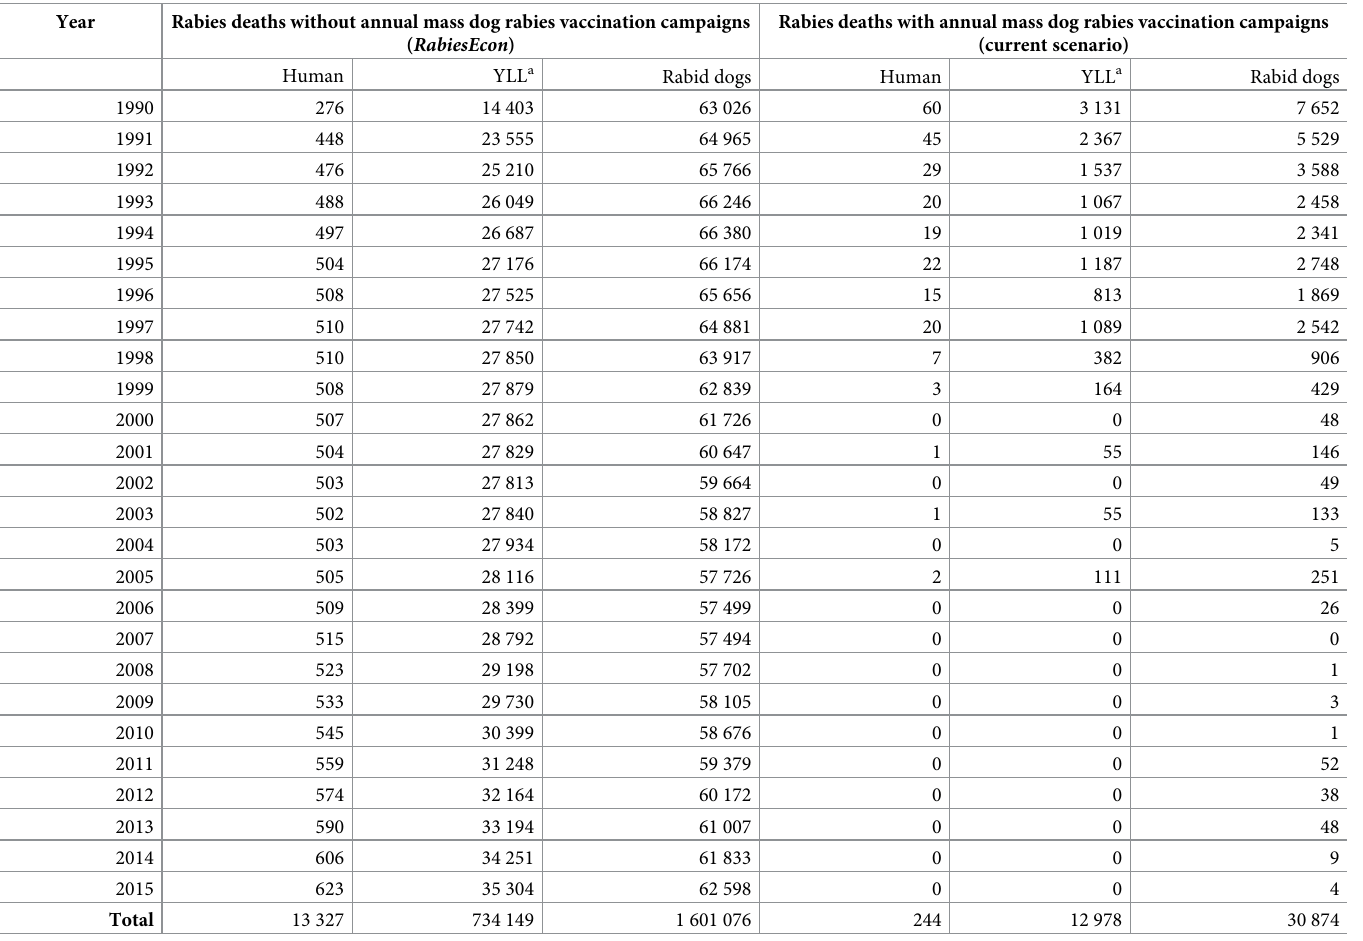
Table 2. Main estimated health indicators for the national program of rabies control in Mexico 1990–2015: dog-mediated human rabies deaths, years of life lost (YLL), and number of rabid dogs. Year Rabies deaths without annual mass dog rabies vaccination campaigns ( RabiesEcon